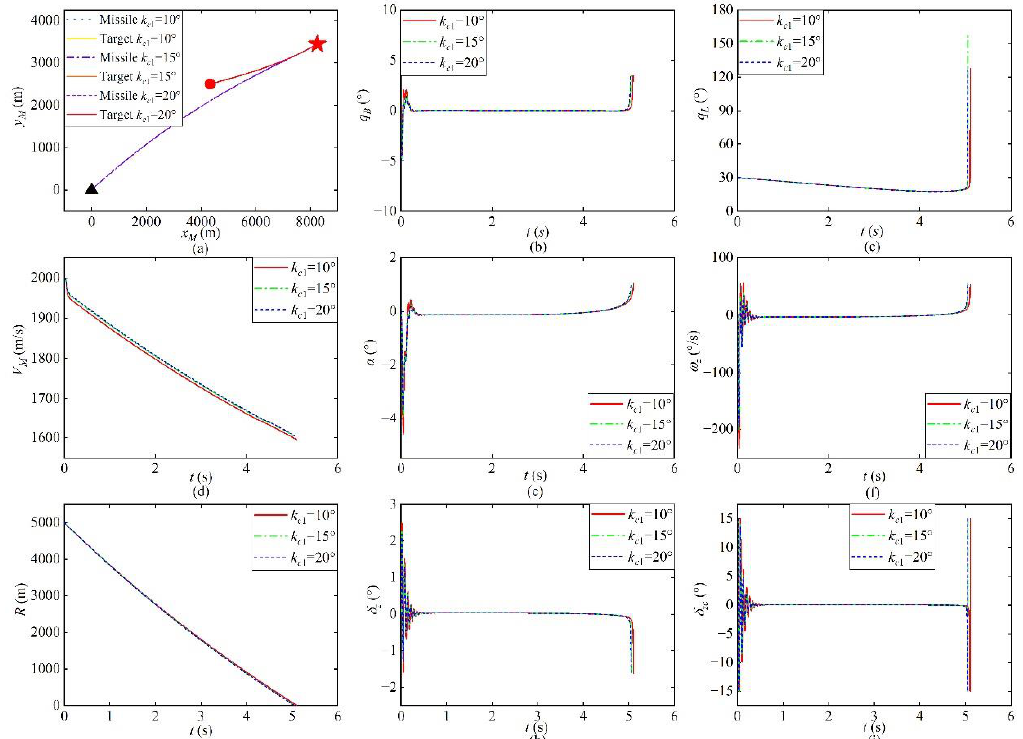
Figure 4. Simulation results under Case 2. ( a ) Missile – target pursuit trajectory. ( b ) The BLOS angle. ( c ) The LOS angle. ( d ) The velocity of missile. ( e ) The angle of attack. ( f ) The pitch angular rate. ( g ) The relative missile-target distance. ( h ) The deflection angle. ( i ) The control input. Table 4. Simulation results under Case